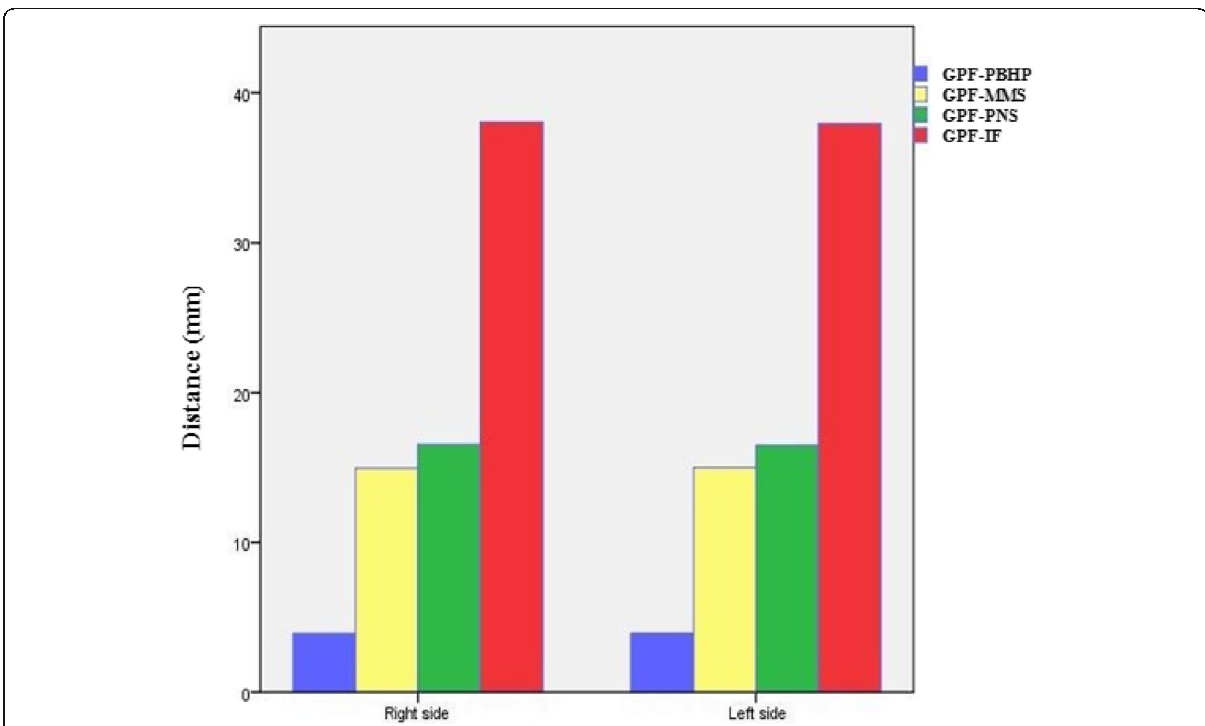
Fig. 13 Bar chart of the distances taken from the center of GPF to surrounding anatomical landmarks based on